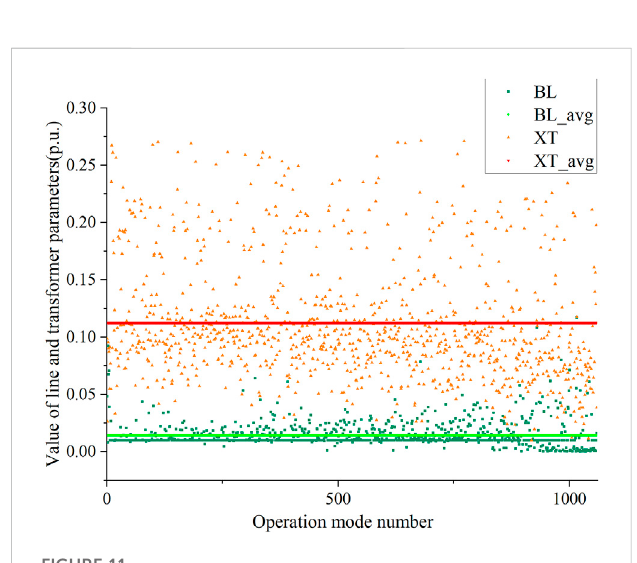
Comparison of equivalent line and transformer parameters and their averages.